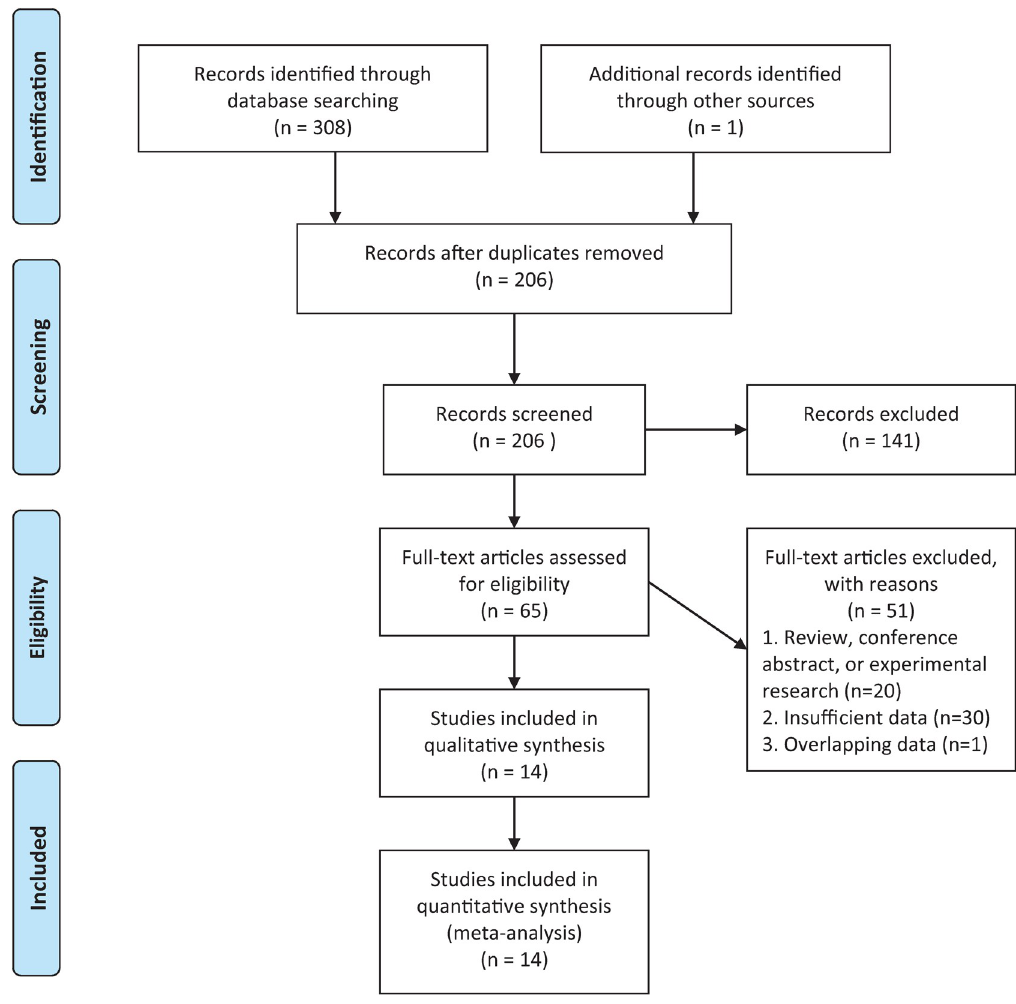
Fig 1. PRISMA flow diagram of the literature search in this